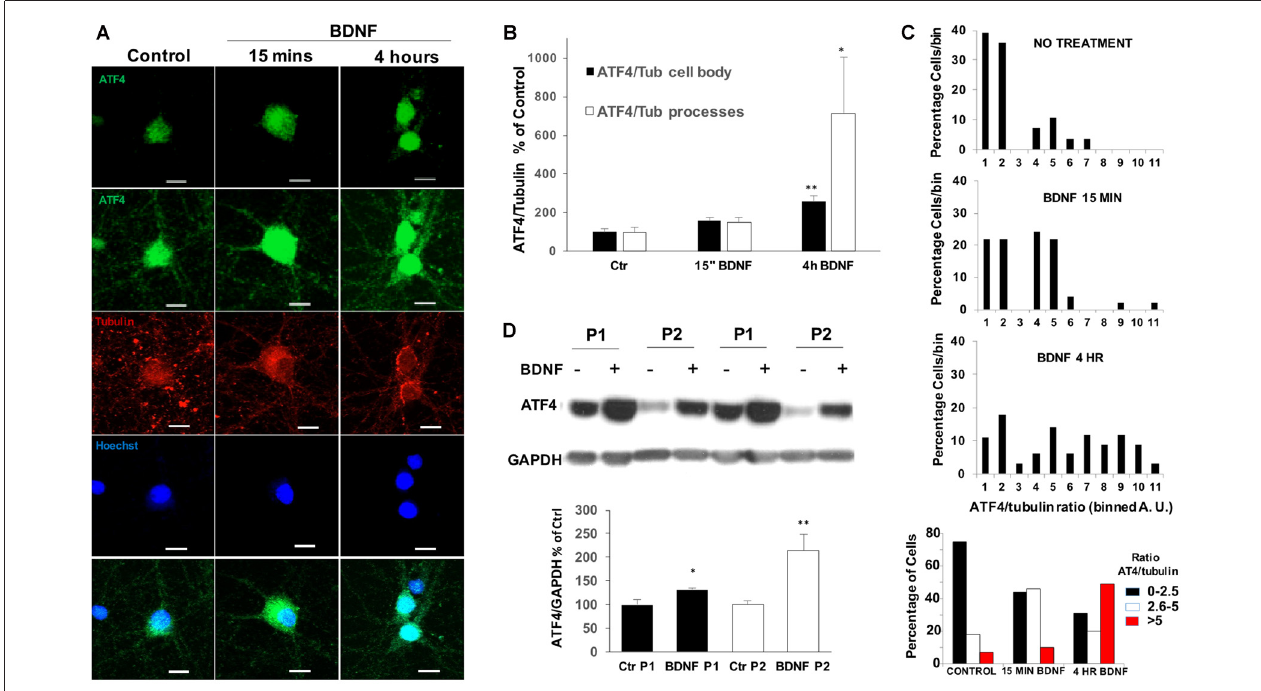
FIGURE 2 | BDNF upregulates ATF4 expression in processes, cell bodies and nuclei of cultured hippocampal neurons. (A) DIV 21 hippocampal neurons were treated with 25 ng/ml of BDNF or vehicle for 15 mins or 4 h, then immunofluorescently labeled for ATF4 (green) and beta-3-tubulin (red) and for Hoescht 33342 staining (blue). The second row shows a longer exposure to reveal processes. Representative images are shown. Scale bar = 10 µ m. (B) Quantification of the ATF4 immunostaining fluorescence intensity of cell bodies and processes for the cultured neurons described in (A) . Details for the separate quantification in cell bodies and processes are given in Experimental Procedures. Data were used to compute the intensity ratios for ATF4 vs. beta-3-tubulin at each time with the ratios at time 0 set to 100%. n = 28–42 randomly chosen cell bodies and 7–9 randomly chosen neurite fields per group. Values are means ± SEM. ∗∗ p = 0.0001, ∗ p = 0.008 compared with controls. p values were calculated vs. contol using the Kruskal-Wallis test (overall p = 0.002) with the post hoc Conover method adjusted by the FDR procedure of Benjamini-Hochberg. (C) BDNF changes the expression of ATF4 in a subpopulation of hippocampal neurons. The values (in arbitary units, A.U.) for ATF4/beta-3-tubulin immunofluorescence ratios in individual cell bodies were determined as in (B) and grouped into bins (from 1 A.U to 11 A.U. in the three upper panels and as indicated in the lower panel). Graphs show the distributions of percentages of cell bodies in each bin at different times of BDNF treatment. n = 28–42 randomly chosen cells per time point. (D) BDNF treatment (4 h, 25 ng/ml) increases ATF4 protein in both nuclear-enriched and synaptosomal-enriched cell fractions. DIV 21 hippocampal neurons treated with BDNF or vehicle were separated into nuclear-enriched (P1, black bars) and synaptosomal-enriched (P2, white bars) fractions as described in “Materials and Methods” section and ATF4 protein levels were determined by Western immunoblotting. Upper panel shows a representative immunoblot, lower panel quantification with values for control set at 100. Values are means ± SEM, n = 3 independent experiments, each with duplicate cell lysates. ∗ p < 0.029, ∗∗ p < 0.014 vs. controls (no BDNF), t